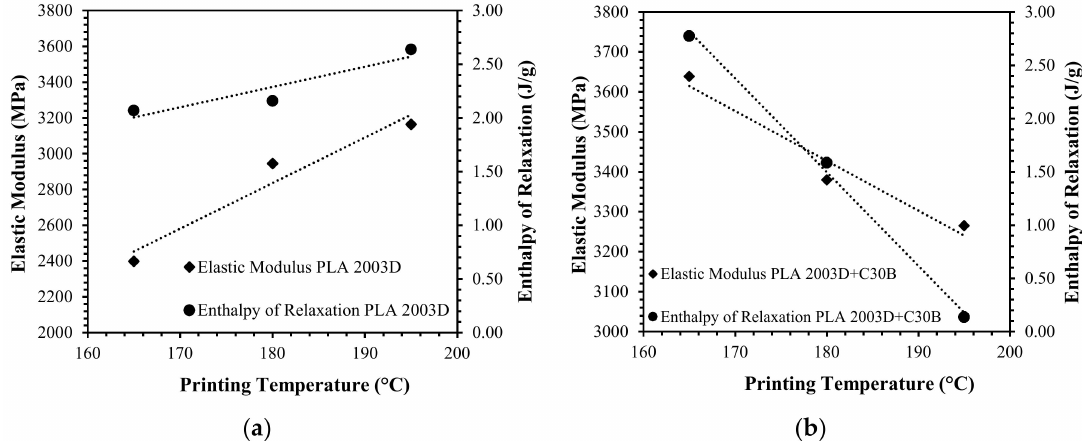
Figure 13. Correlation between elastic modulus and enthalpy of relaxation and 3D printing temperature for PLA 2003D ( a ) and PLA 2003D+C30B ( b